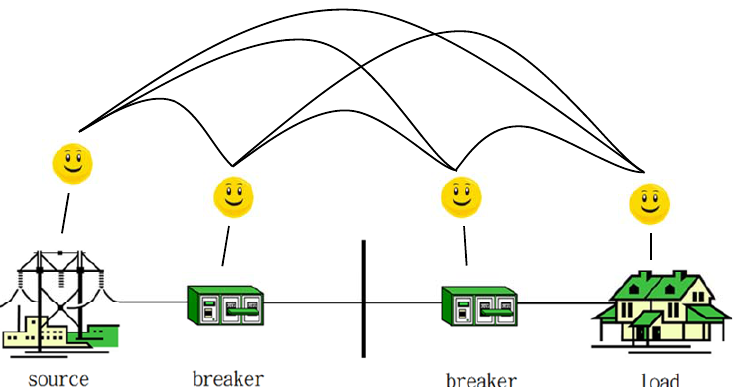
Figure 2. Diagram of multi-agent system.